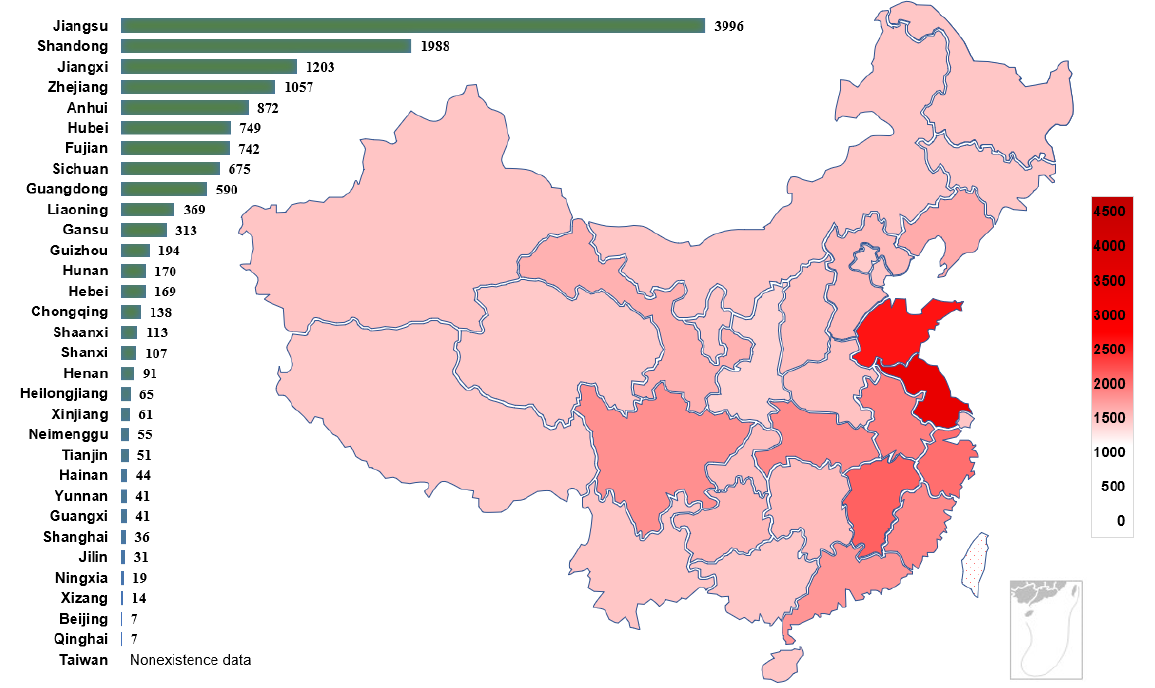
Figure 3. Regional distribution of enterprises in China’s hazardous chemical industry as of 2022 (mainland only). Note: Beijing, Tianjin, Shanghai, and Chongqing are municipalities.